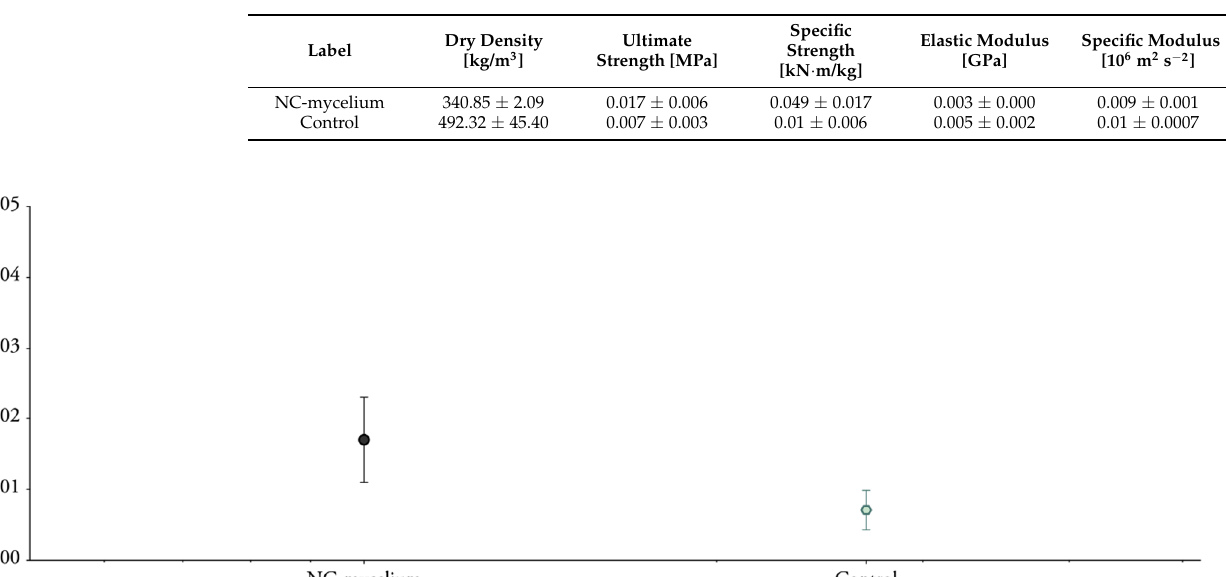
Figure 12. Internal bond strength of nanoclay–mycelium composite. Labels with different letters indicate a statistical difference ( p < 0.05) among the specimens.